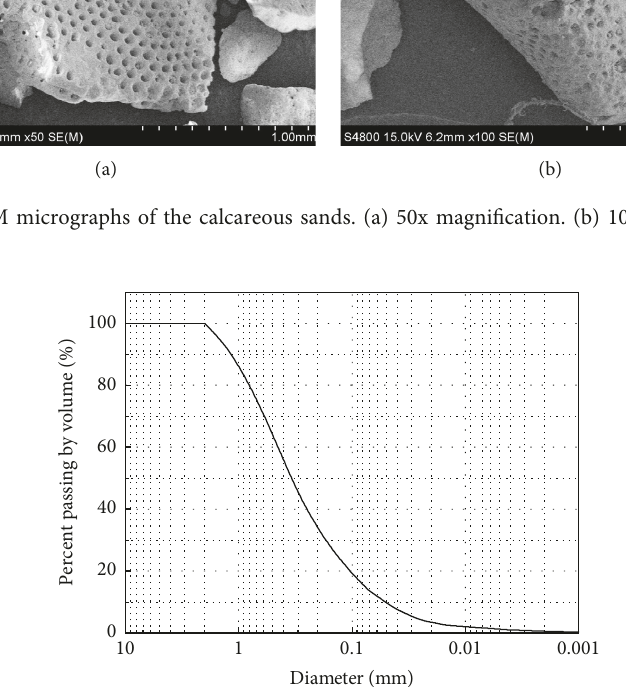
Figure 2: Particle size distribution curve of both sands.